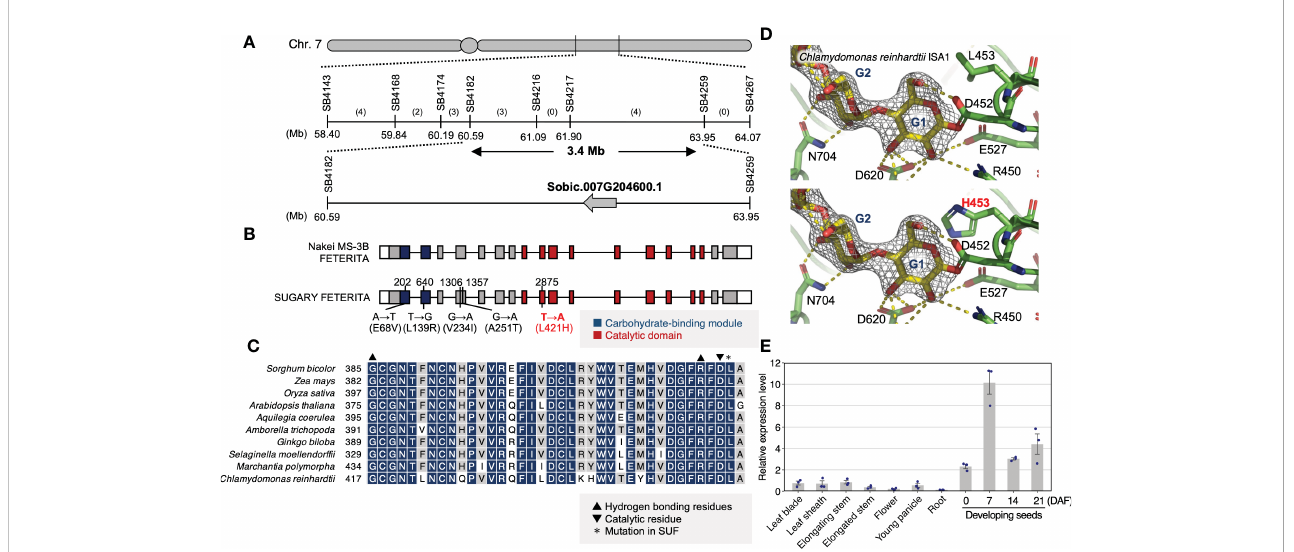
FIGURE 2 Positional cloning of the corresponding gene for sugary endosperm in ‘ SUGARY FETERITA ’ . (A) A high-resolution map of the candidate locus on chromosome 7. Vertical lines indicate the positions of the SSR markers with their physical positions (Mb) in Phytozome 13 ( Sorghum bicolor v3.1.1). The number of recombinants is shown between the markers. The mapping analysis narrowed the candidate region to a 3.4 Mb stretch between SB4182 and SB4259 on the long arm of chromosome 7. Around 400 genes were annotated in this region, including Sobic.007G204600. (B) Gene structures of SbSu according to the three cultivars, ‘ Nakei MS-3B ’ (MS3B), ‘ FETERITA ’ (FET), and ‘ SUGARY FETERITA ’ (SUF). Exons are represented as boxes and introns as the lines between boxes. White, grey, black, and red boxes indicate the 3 ’ - or 5 ’ -untranslated regions (UTR), protein-coding regions, a carbohydrate-binding module, and a catalytic domain, respectively. SUF has fi ve SNPs in its coding region compared to the MS3B and FET alleles. (C) The conservation of L421 among plants and algae is indicated with an asterisk. It is located in the catalytic domain, indicated by an inverted triangle. ( D , top) The expanded structure of Chlamydomonas reinhardtii Isoamylase 1 (CrISA1) obtained from PDBj (Protein Data Bank Japan, PDB DOI: 10.2210/pdb4J7R/pdb) and visualized in PyMOL v2.1. The L453 in C reinhardtii , which corresponds to L421 in FET, was substituted to Histidine (bottom, highlighted in red). (E) Expression pattern of SbSu among organs. Error bars indicate the standard error of three biological